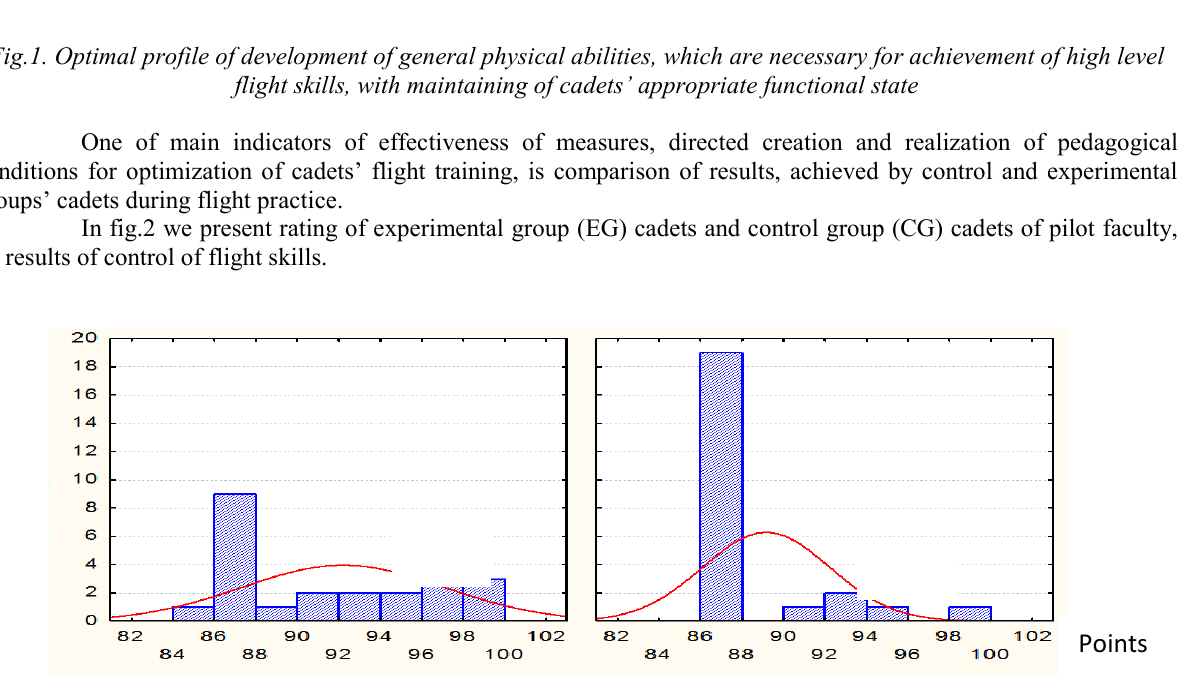
Fig.1. Histogram of distribution of EG and CG cadets of pilot faculty by results of rating control of flight skills’